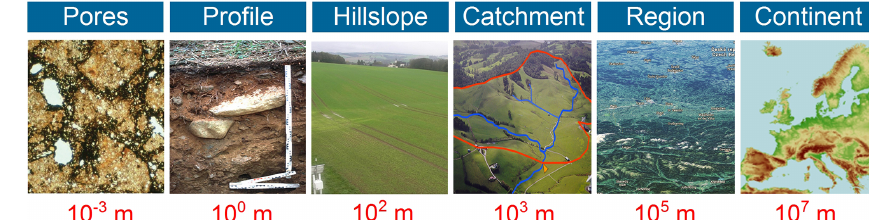
Figure 1. Scale transitions across 10 orders of magnitude.